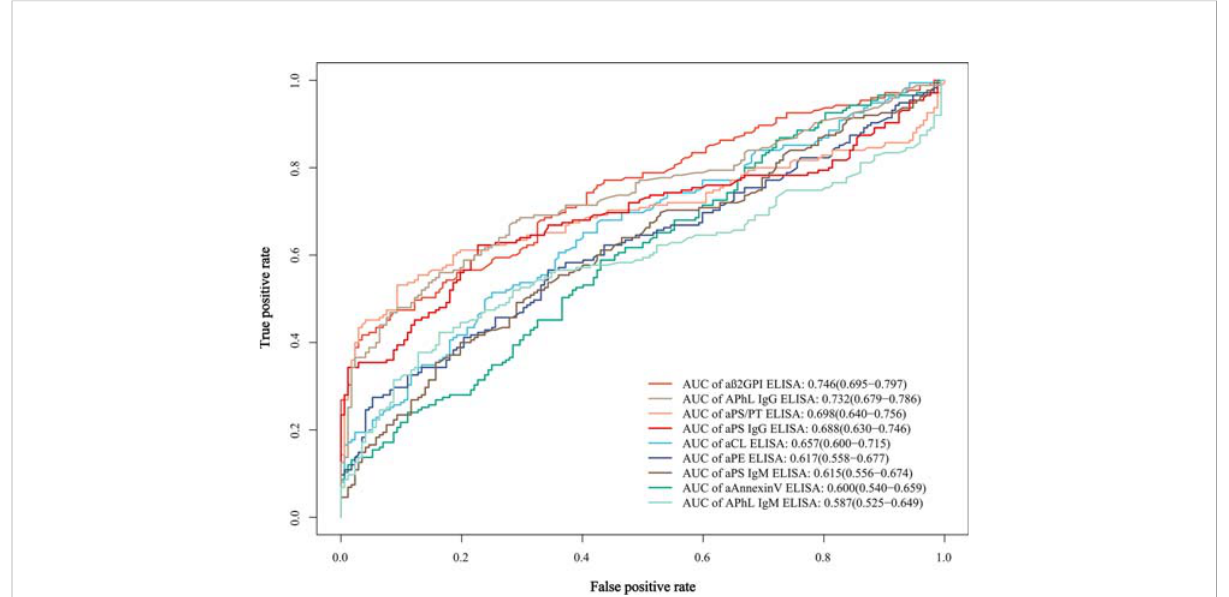
FIGURE 1 Receiver operating characteristic (ROC) curves and area under the curve (AUC) of the single aPLs. AUC values of each curve are shown with 95% con fi dence interval (CI) and are listed in a descending order.